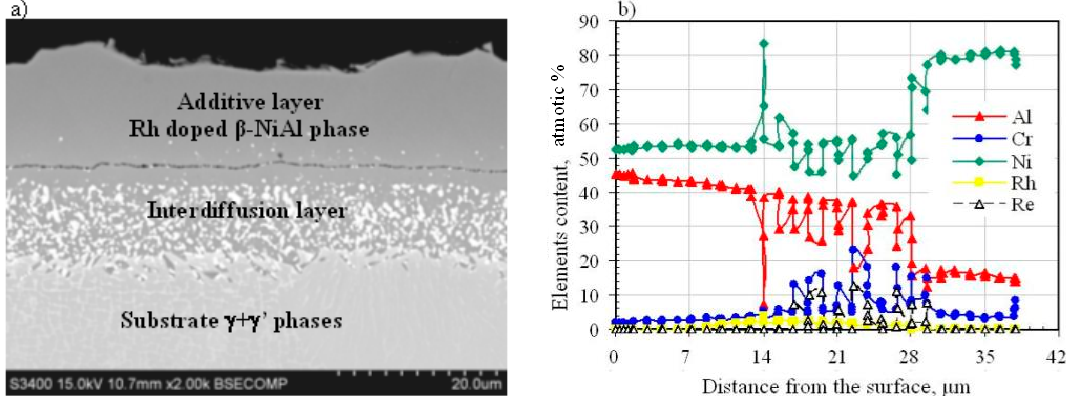
Figure 6. Microstructure ( a ) and elements’ distribution ( b ) on the cross-section of the rhodium-modified aluminide coating.